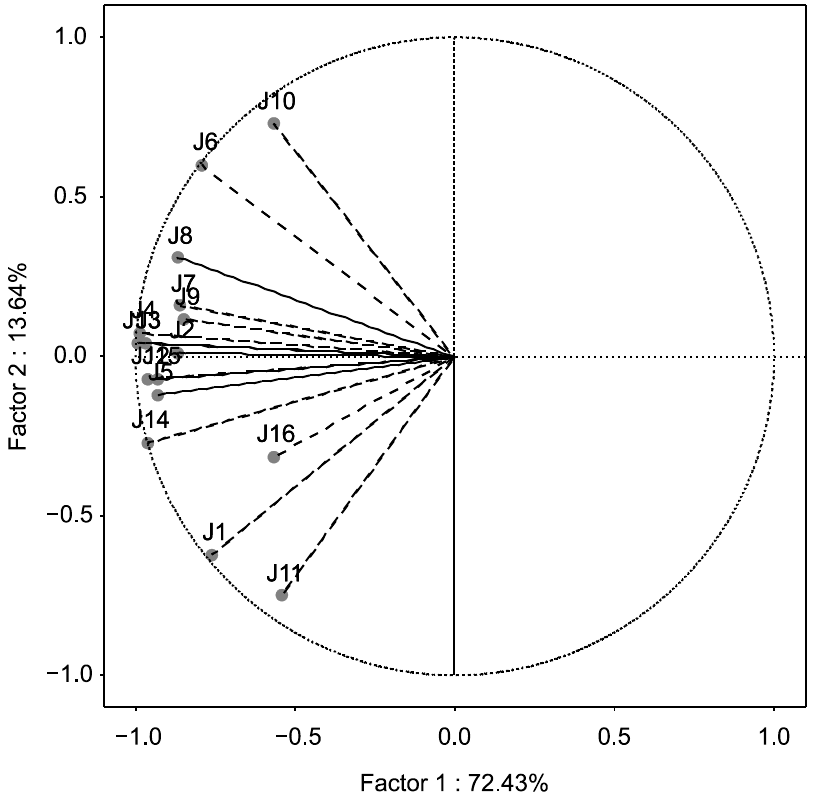
Figure 3. Projection of the variables on the factor-plane extracted by PCA corresponding to the vegetal attribute.